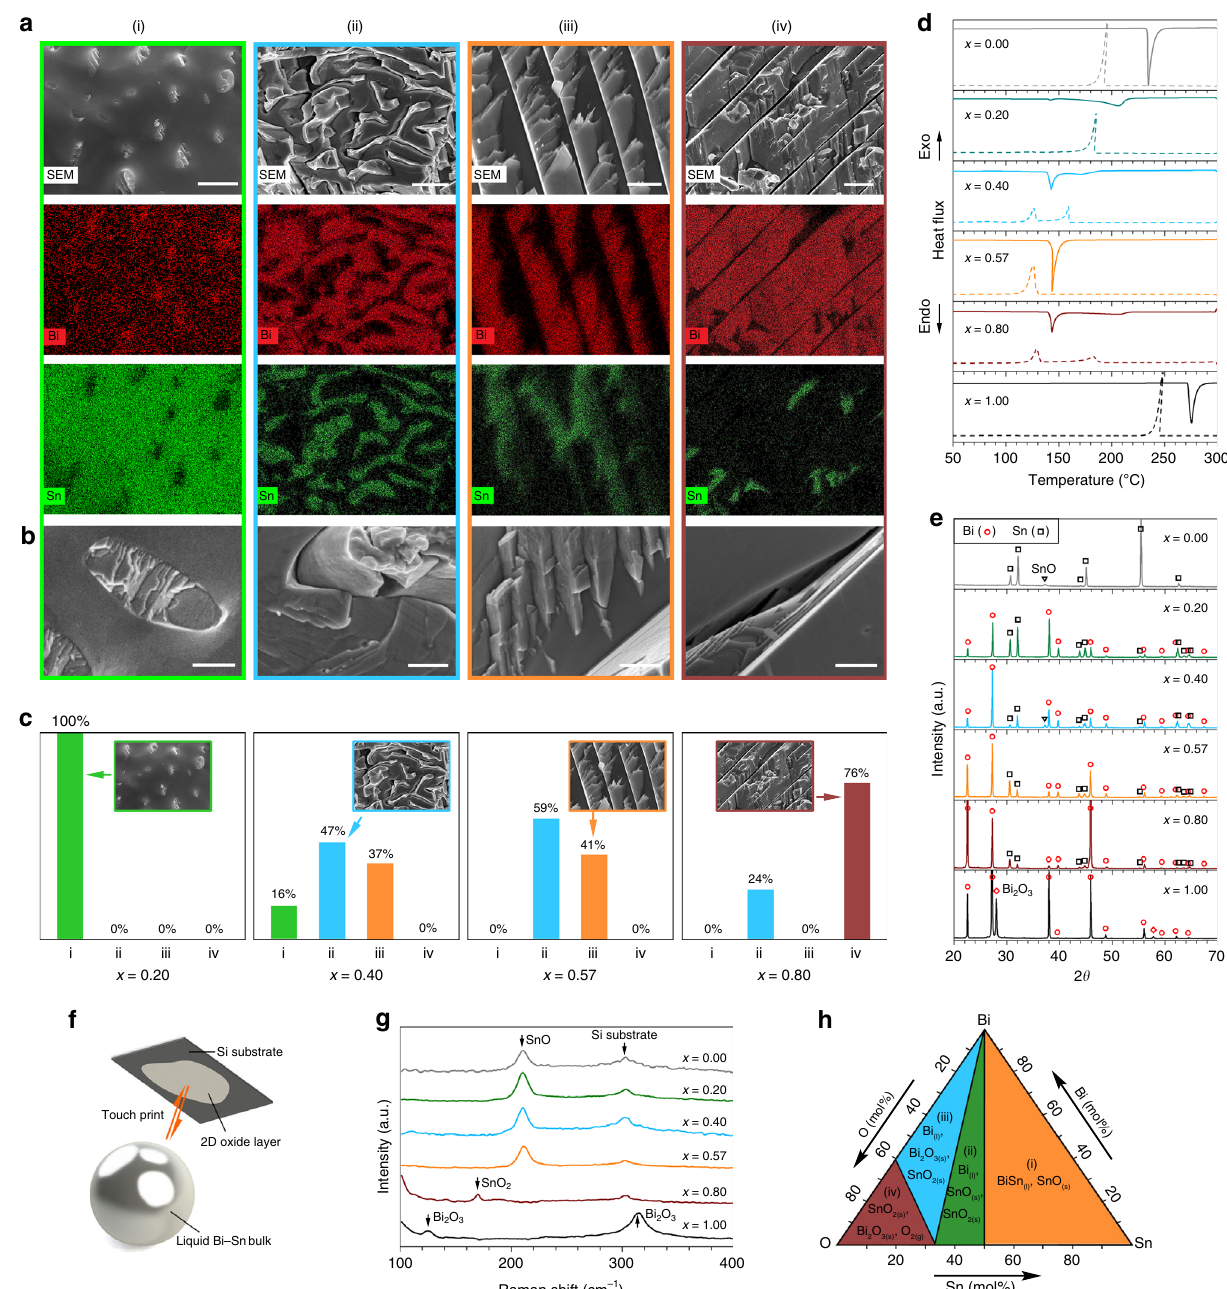
Fig. 2 Characterisation of Bi x Sn 1- x bulk alloys. a SEM images and EDX element mappings showing the distribution of the Bi and Sn phases in four types of solidi fi cation structures observed in the Bi – Sn bulk alloys. Scale bars: (i) 2 µ m; (ii) 5 µ m; (iii) 2 µ m; (iv) 5 µ m. b Magni fi ed views of different solidi fi cation structures. Scale bars: 500 nm. c Distribution of different solidi fi cation structures in different Bi – Sn bulk alloys. d DSC curves showing the melting (solid lines) and solidi fi cation (dash lines) trends of the bulk samples. e XRD patterns of the bulk samples. f Schematics of touch-printed surface oxide layer from liquid Bi – Sn bulk samples. g Raman spectra of the touch-printed surface oxide layers from bulk liquid Bi – Sn samples. h Phase diagram of the Bi – Sn – O system calculated at 300 °C, 1 atm